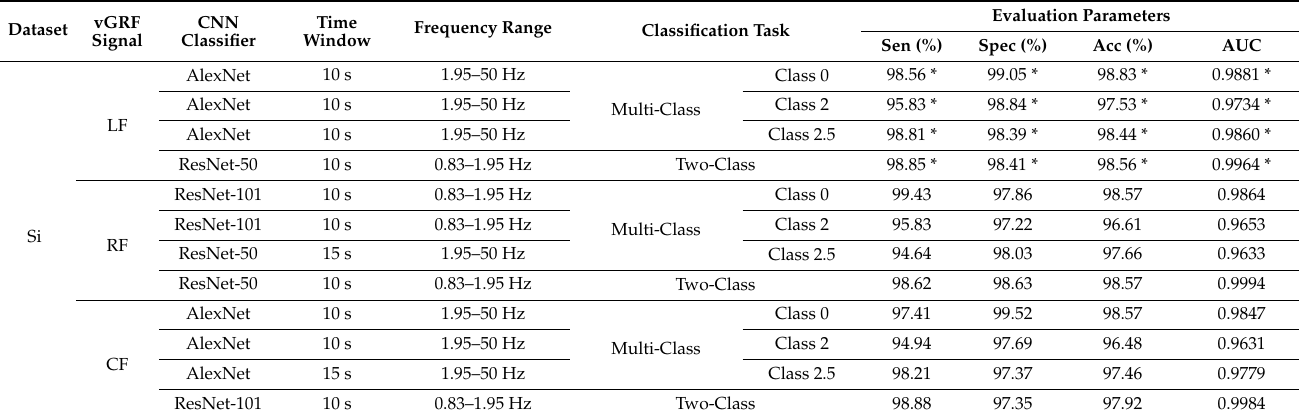
Table 22. Multi-class (CO (Class 0) vs. PD Stage 2 (Class 2) vs. PD Stage 2.5 (Class 2.5), and PD Stage 3 (Class 3)) and two-class classification (CO vs. PD (Class 2, Class 2.5, and Class 3)) summary using several CNN classifiers (AlexNet, ResNet-50, ResNet-101, and GoogLeNet) with 10-fold cross-validation for Si dataset.